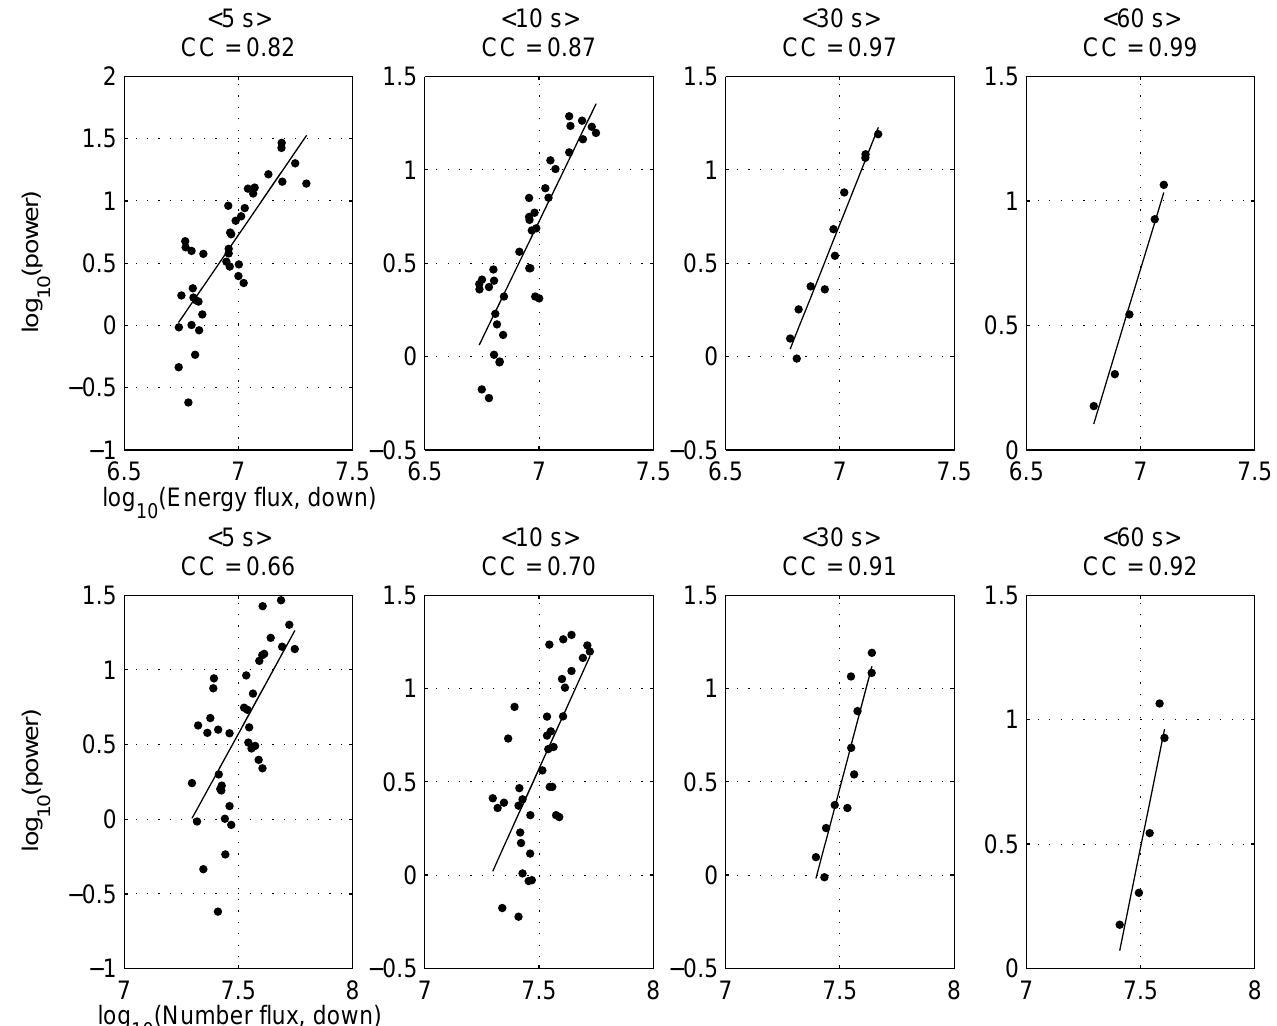
Fig. 3. Plots of BB-ELF wave power versus ion fluxes for the 6 September 2001 cusp pass by Cluster 4. The top row shows ion energy flux, the bottom ion number flux. The four columns show how the correlation varies with different time averaging. For each panel the x-axis is the logarithm of the average flux within the window and the y-axis is the logarithm of the average electric field power in the range 0.75–11Hz within the window. The data is plotted as points, and the lines are linear fits. Above each panel is the correlation coefficient (CC) for the linear fit shown in that